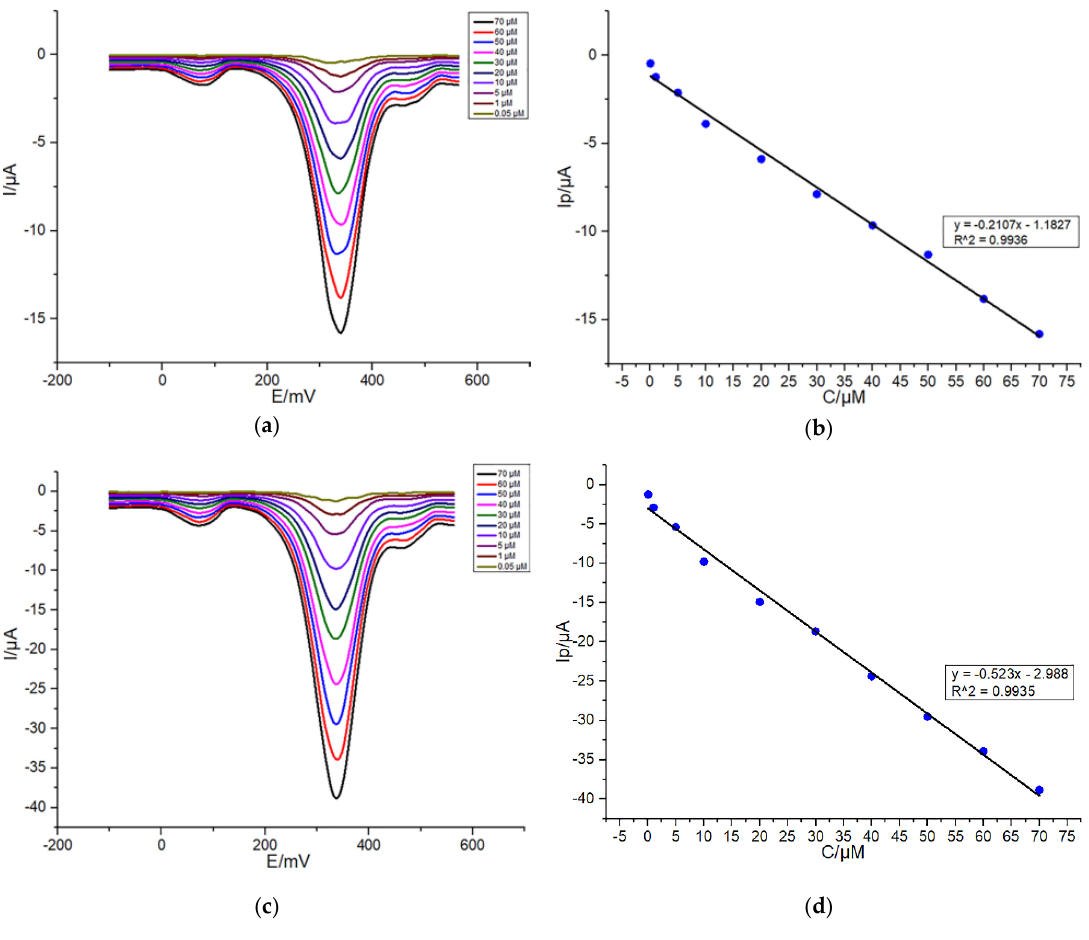
Figure 6. DPV responses of varying concentrations of DA from 0.05 to 70 μM in the presence of a mixture of 30-μM AA and 30-μM UA in 0.1-M PBS (pH: 7.4, 0.1-M KCl) at G/SPE ( a ) and PEDOT:PSS/CS–G/SPE ( c ); ( b, d ) plots of peak currents of DA oxidation versus DA concentrations. Detection parameters: potential range from −100 to +560 mV, 50 -mV pulse amplitude, 2-mV step potential, 0.05-s pulse width. Table 1. Comparison of our PEDOT:PSS/CS–G/SPE using a self-designed detection system with other modified electrodes using various methods reported in the literature for the determination of DA.